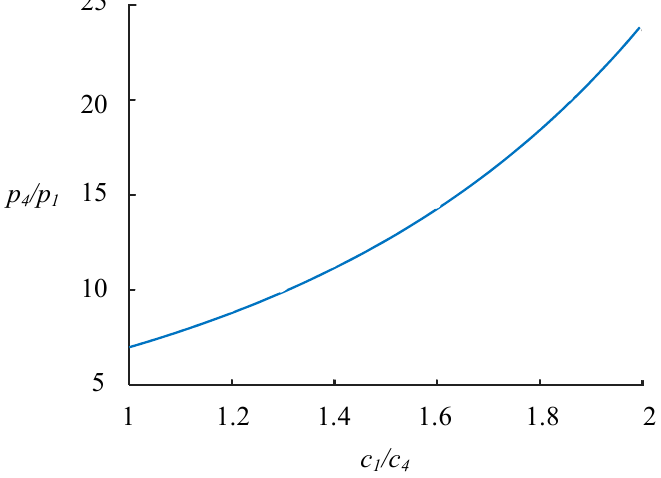
Figure 10. The relationship between equivalent sound ratio and pressure ratio.